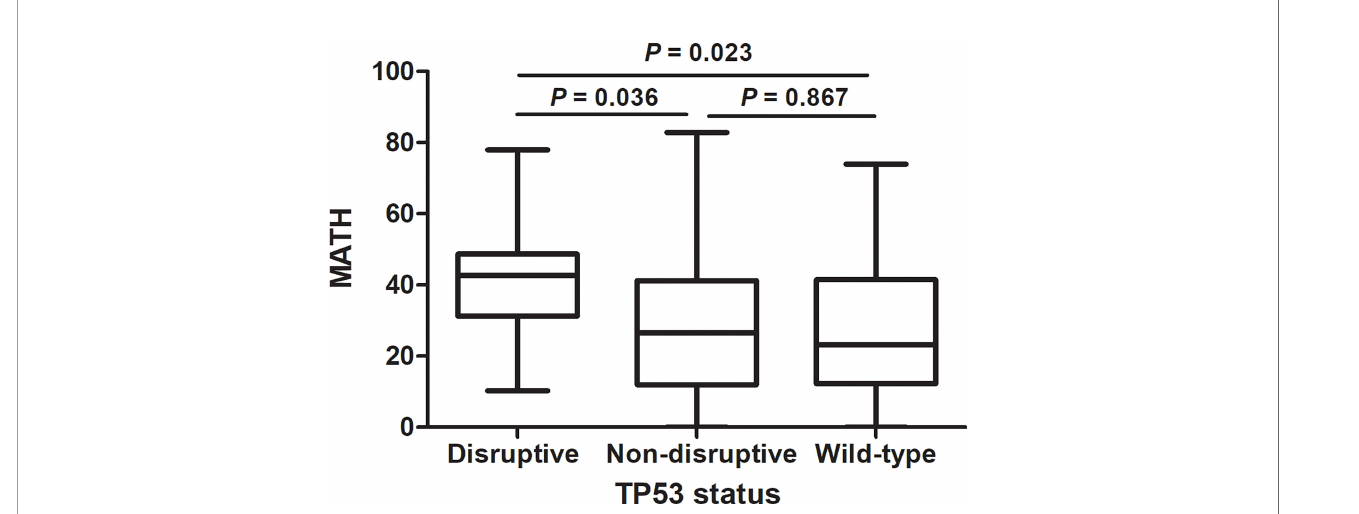
FIGURE 3 | Relation of mutant-allele tumor heterogeneity (MATH) to TP53 mutation status in lung adenocarcinoma. MATH was higher in patients having disruptive TP53 mutations than in those with non-disruptive mutations (P = 0.036) or wild-type sequence (P =